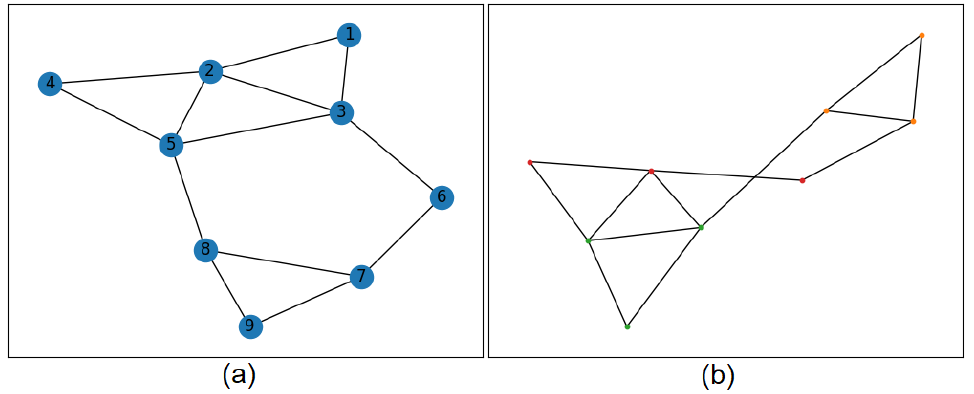
Figure 22. Overview of community detection, ( a ) G with nine nodes, and ( b ) G with three